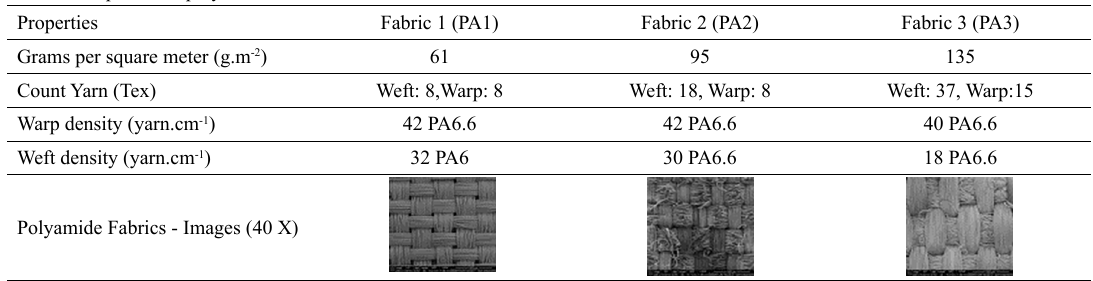
Table 1. Properties of polyamide fabrics. Properties